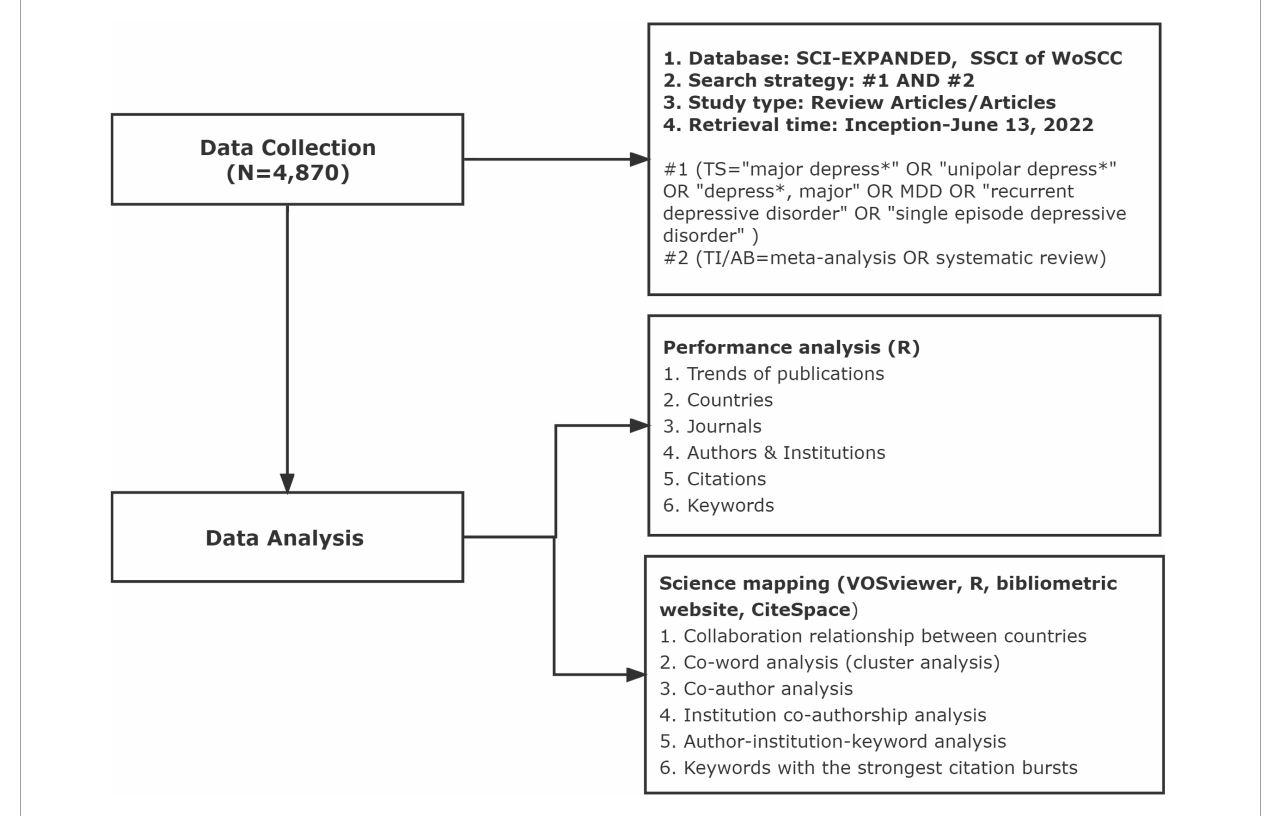
FIGURE1 Flowchart of data collection and study